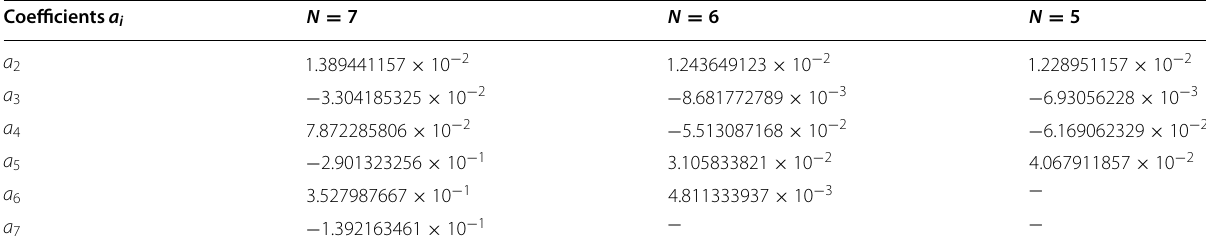
Table 6 Coefficients a i for various N of Rayleigh–Ritz procedure in case (2)